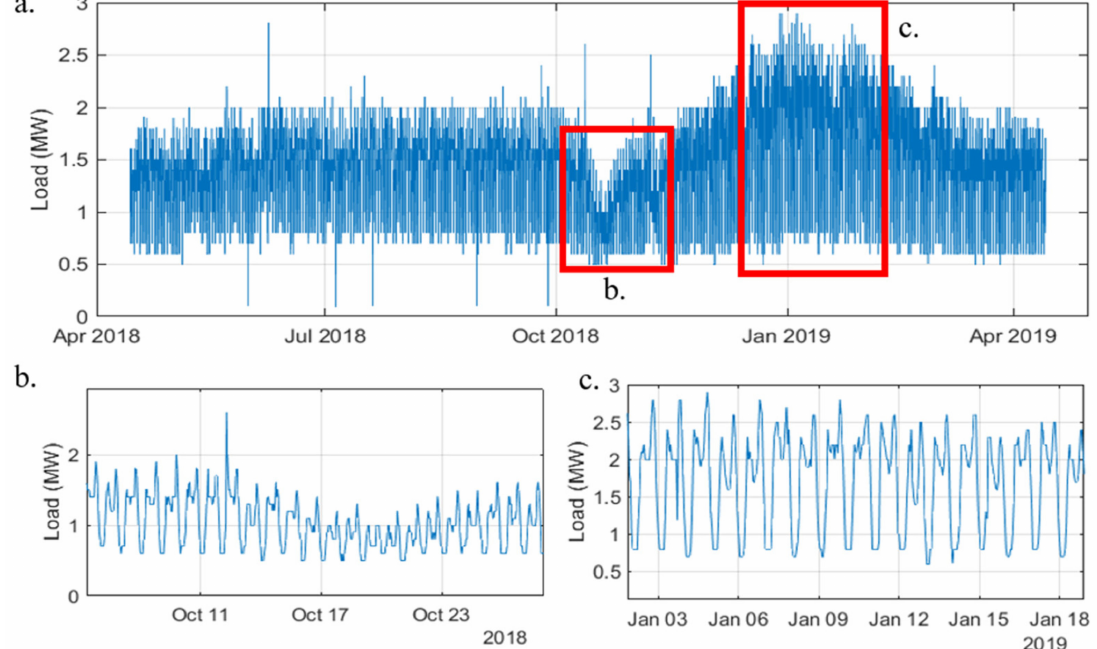
Figure 1. ( a ) One year of hourly load demand at a Baneshwor substation (from April 2018 to April 2019). ( b ) Zoomed in section of electricity consumption in October (lower consumption). ( c ) Zoomed in section of electricity consumption in January (high consumption).